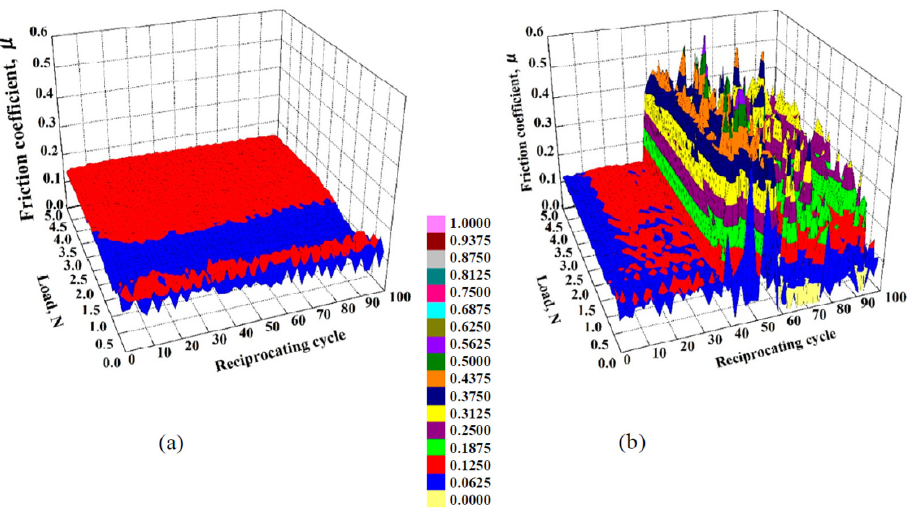
Figure 5. Friction properties of 1.0 nm FCVA-DLC films at various temperatures. ( a ) RT; ( b ) 200 °C.